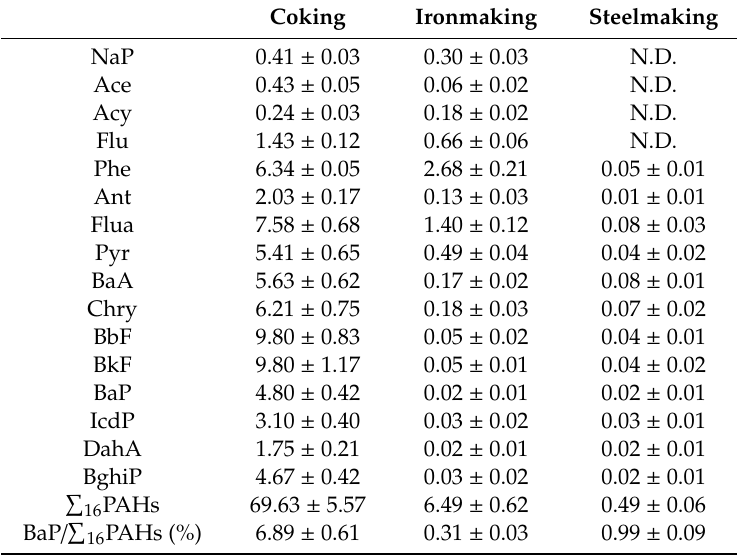
Coking Ironmaking Steelmaking